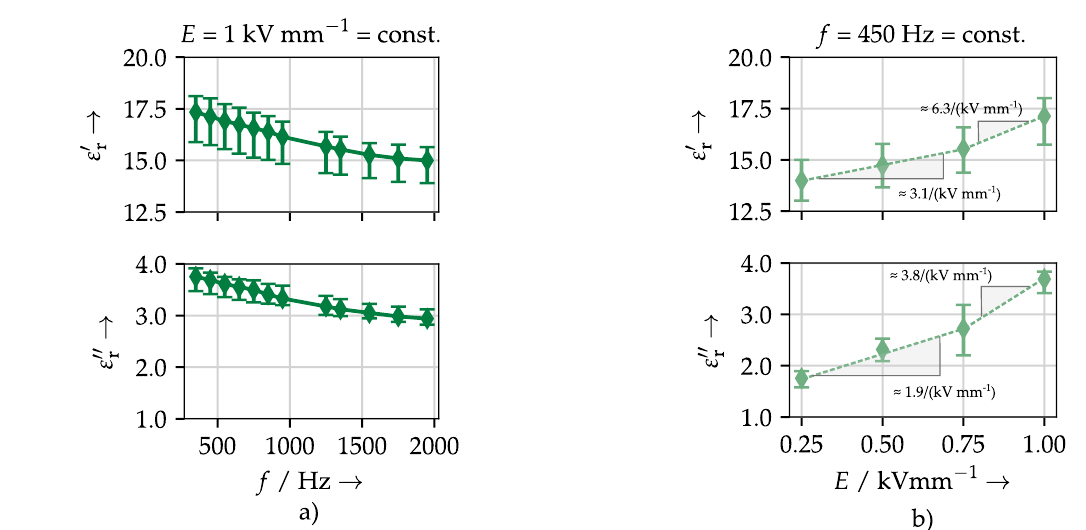
Figure 7. Real and imaginary part of the complex permittivity of f-SiR as a function of ( a ) frequency and ( b ) elec- tric field strength, the mean and range of three test objects, approximated increases for ( 0.25 ... 0.75 ) kVmm − 1 and ( 0.75 ... 1 ) kVmm − 1